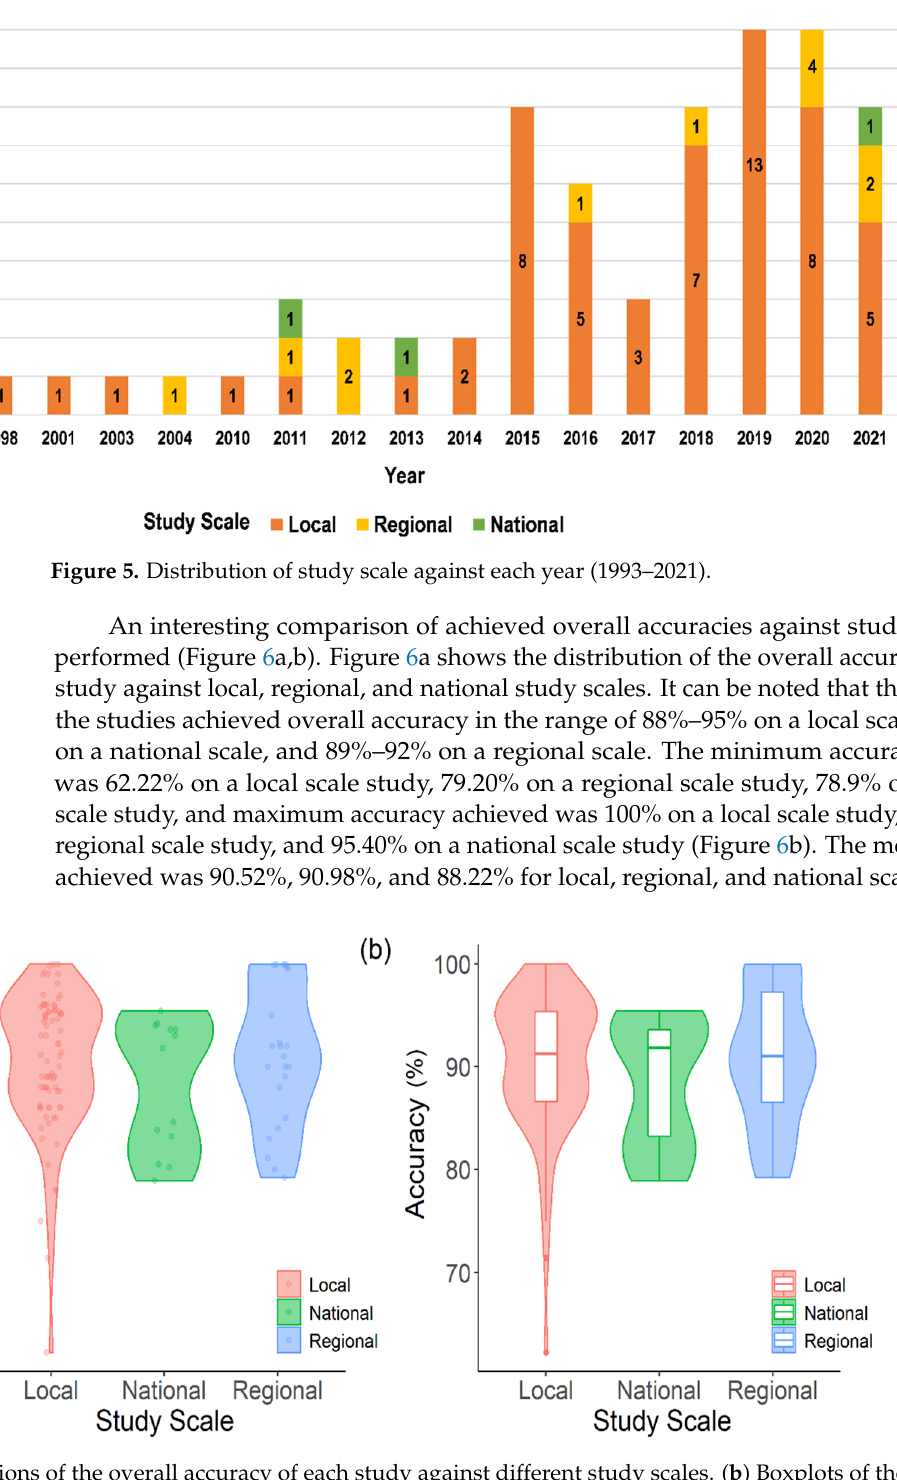
Figure 6. ( a ) Distributions of the overall accuracy of each study against different study scales. ( b ) Boxplots of the overall accuracy of each study against different study scales.